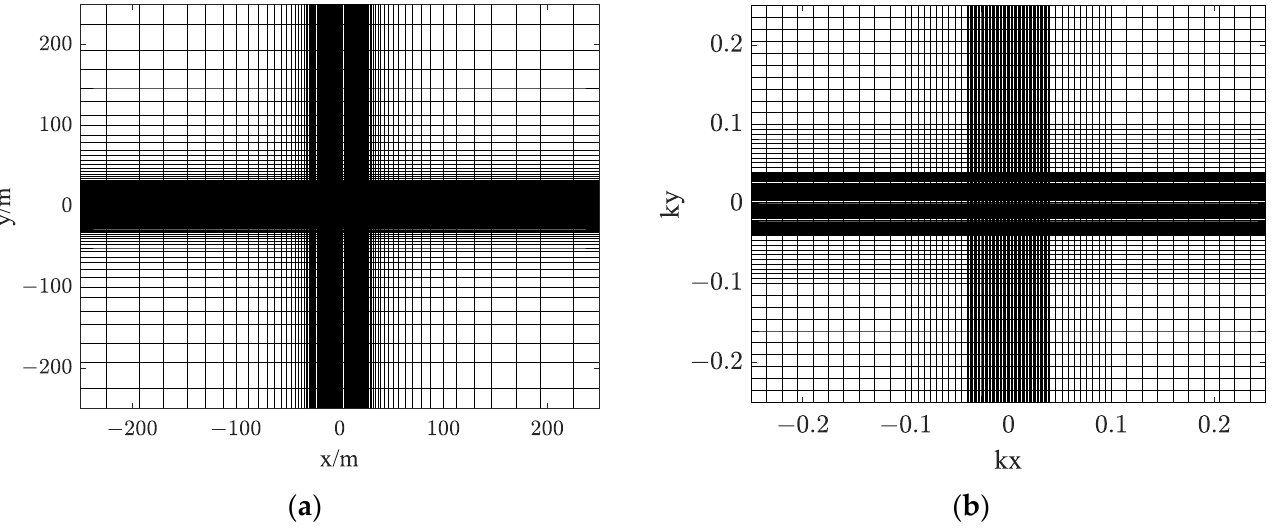
Figure 16. Schematic diagram of horizontal non-uniform sectioning. ( a ) Spatial domain sample, ( b ) Wavenumber domain sample.